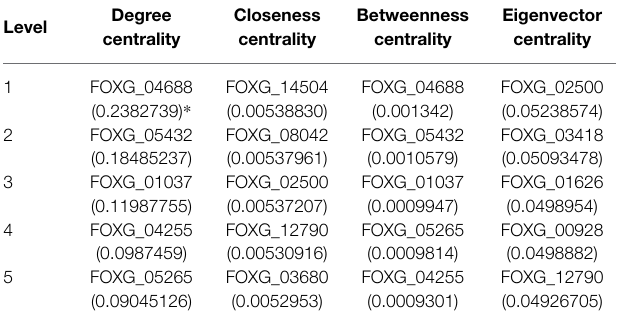
TABLE 2 | Centralities of top 5